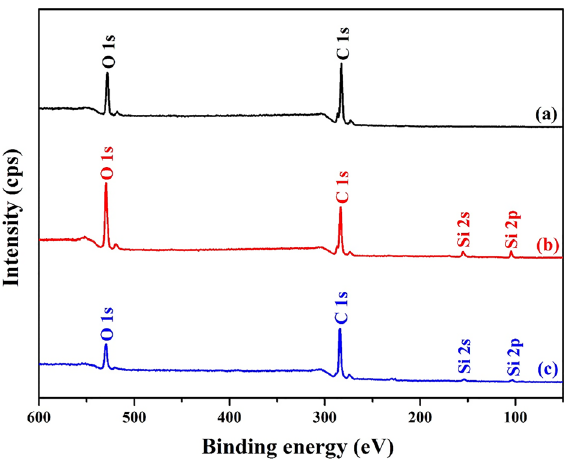
Figure 4. XPS survey scan of ( a ) LA, ( b ) LAPC-1 and ( c )